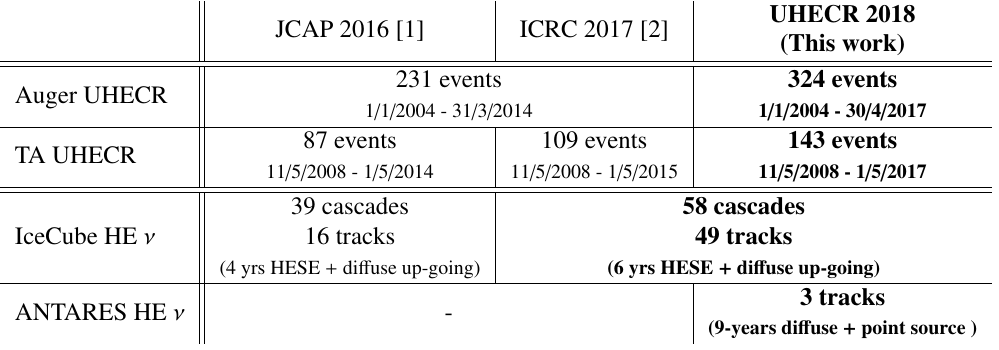
Table 2. Summary of the post-trial p-values obtained in this work compared to previous